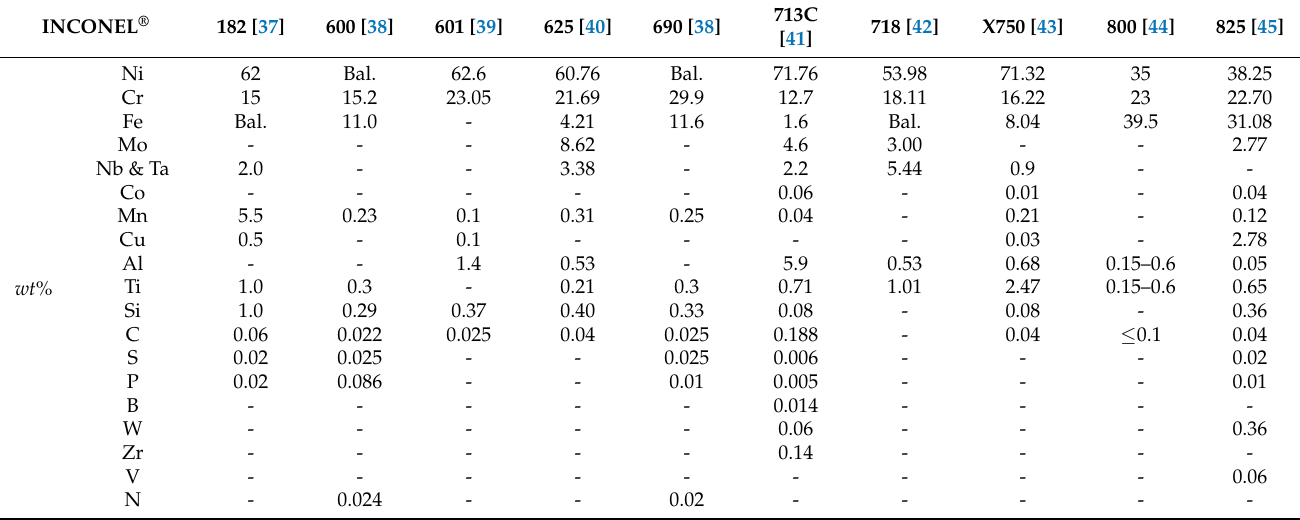
Table 4. Chemical composition of relevant INCONEL ®